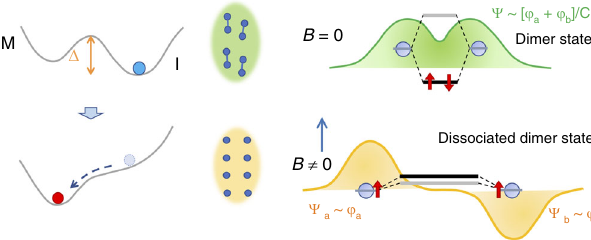
Fig. 7 Schematic of the magnetic- fi eld-induced insulator – metal (MFI – IM) transition. The left side shows that the potential barrier Δ is lowered because of the Zeeman energy. The middle part schematically shows the collapse of the V-V dimers. The right part shows that applying a magnetic fi eld induces the dissociation of the dimer owing to the destabilisation of formation of the bonding state Ψ of the molecular orbital, where φ a and φ b are the wave functions of the independent vanadium ions. ~600 T, assuming a magnetic fi eld variation of Δ α /( α M − α I ) similar to that for x = 0.06. A potential MFI – IM transition in the non-doped VO 2 thin fi lm is expected to be observed at fi elds exceeding 540 T. A 1000-T-class fi elds 23 is necessary to resolve